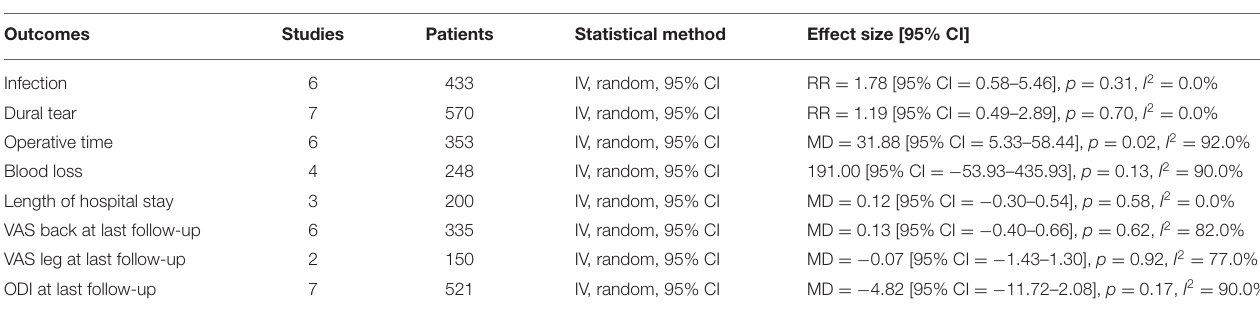
TABLE 2 | Secondary